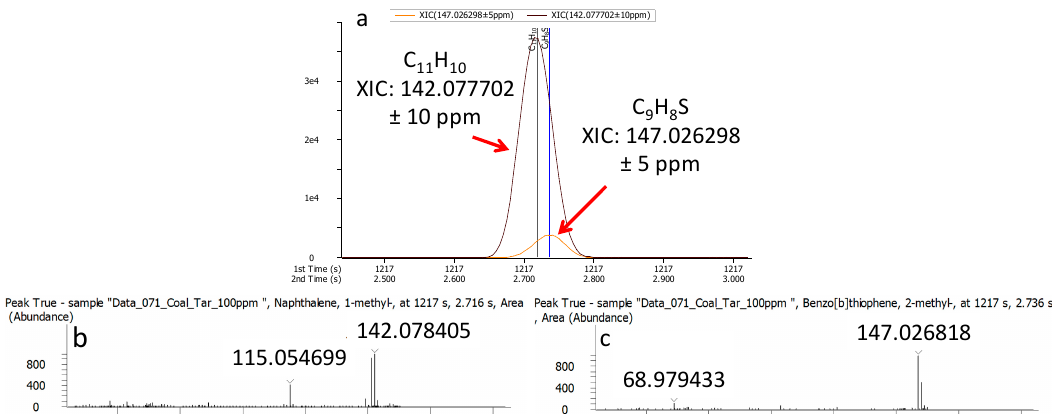
Figure 3. Extracted ion chromatogram expansion highlighting a coelution between C1-BT (spectrally identified as 2-methyl[b]benzothiophene) and C1-N (spectrally identified as 1-methylnaphthalene) ( a ). Deconvoluted mass spectrum for 1-methylnaphthalene ( b ) and 2-methyl[b]benzothiophene ( c ).